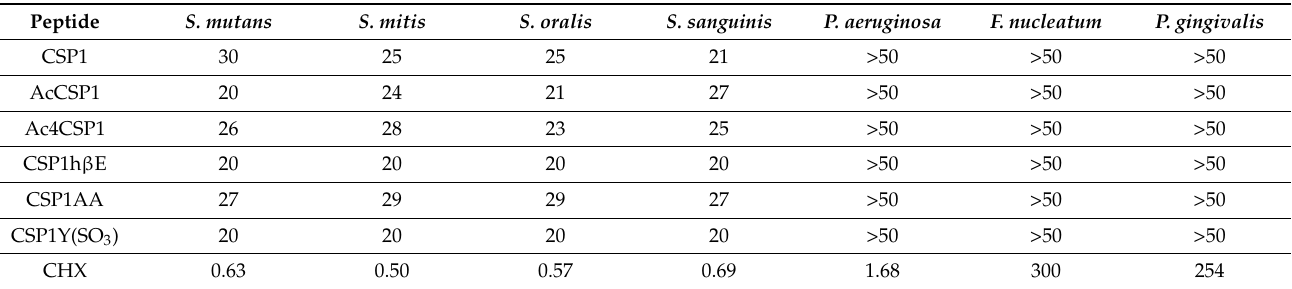
Table 4. Minimum inhibitory